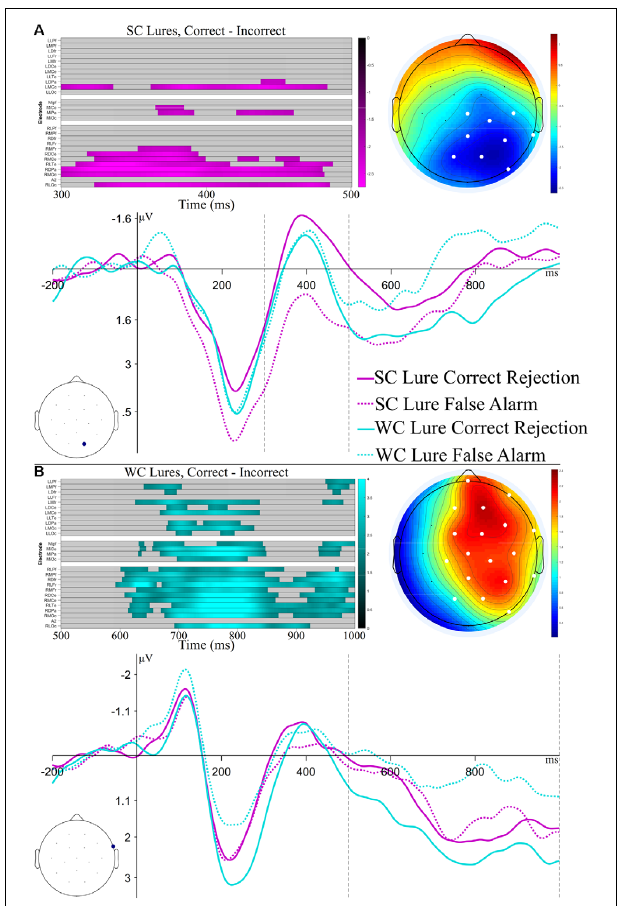
FIGURE 5 | Results and ERP plots for analyses of Lures. The top half (A) focuses on Strong Constraint Lures, with a time window of 300–500 ms, whereas the bottom half (B) focuses on Weak Constraint Lures, with a time window of 500–1,000 ms. The raster plots show channels and time-points which make up the significant cluster found in the permutation tests. Colors represent the t -value at the time-point. The ERP topography plots show the mean amplitude in the time window of the significant cluster, with significant channels highlighted in white. The ERP plots show the SC and WC Lures at the maximal channel within the observed cluster. The black dashed lines indicate the time range of the permutation tests.